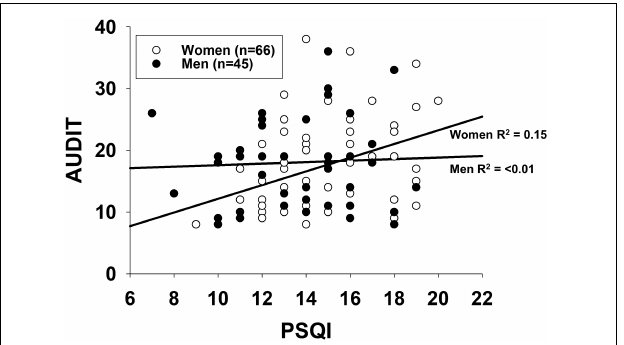
FIGURE 1 | Bivariate correlations of Pittsburgh Sleep Quality Index (PSQI) and Alcohol Use Disorders Identification Test (AUDIT) scores in men and women. PSQI and AUDIT scores were significantly positively correlated in women ( p < 0.01), but not in men ( p = 0.75).